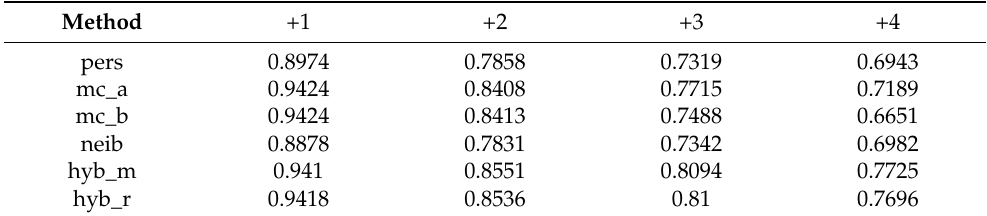
Table A3. Correlation coefficients of predicted and actual CMF time series for 4 lead time steps (+1 to +4) in 2020 for